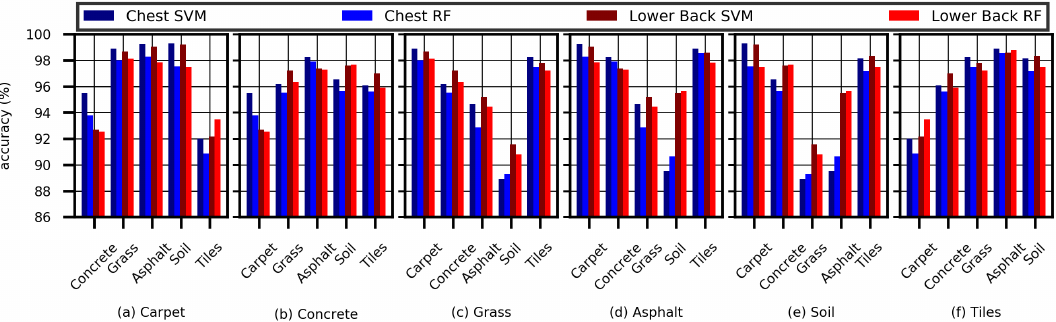
= carpet , C Co = concrete , T T